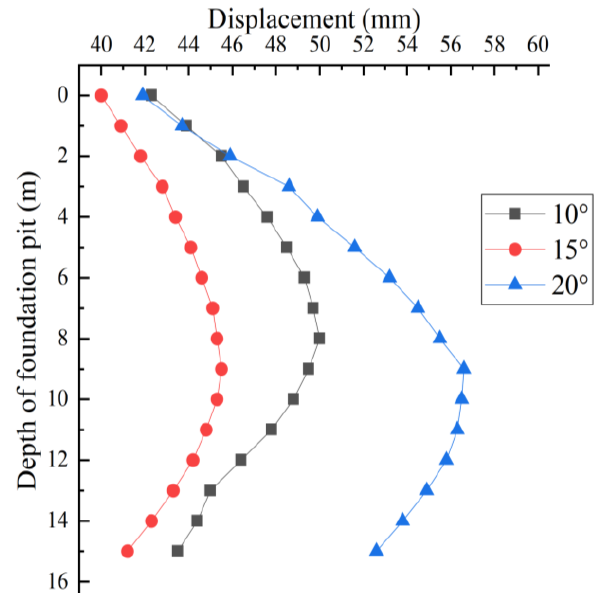
Figure 17. Pile displacement diagram.